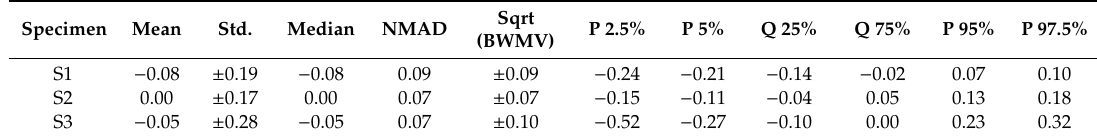
Table 8. Statistical analysis of the signed discrepancies. Units: millimeters. Specimen